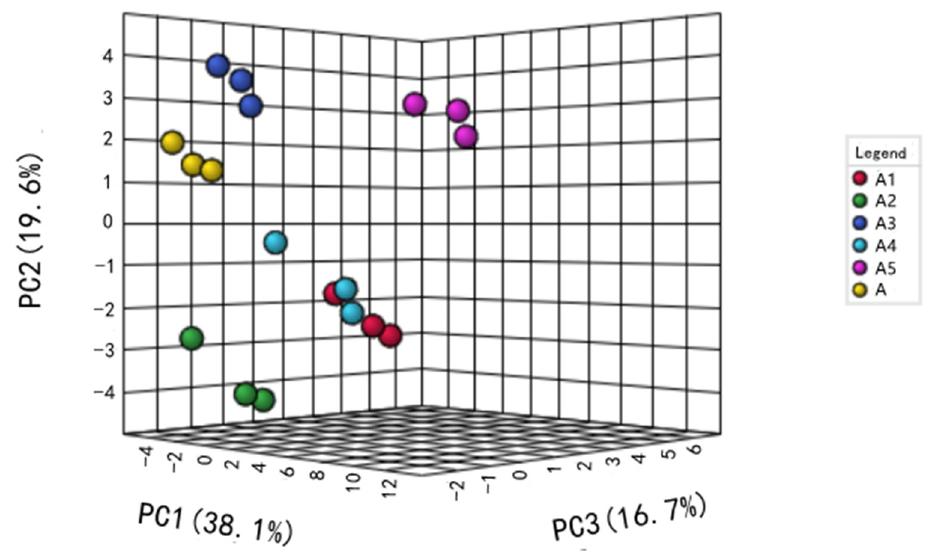
Figure 2. PCA plot of volatile flavour profiles at the end of fermentation. Five different ratios of L. delbrueckii subsp. bulgaricus IMAU20312 and S. thermophilus IMAU80809 were used as mixed starter cultures: A1 = 1:1, A2 = 1:10, A3 = 1:100, A4 = 1:1000, A5 = 1:2000, A = JD (commercial yogurt starter culture as a control).